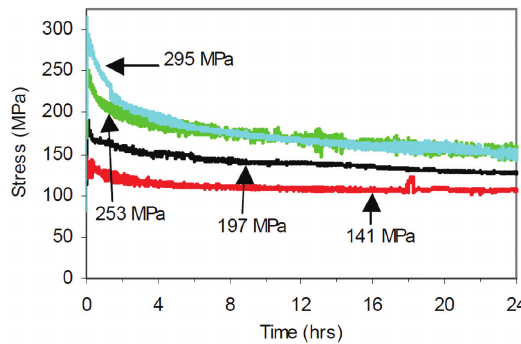
Figure 3. Example of the effect of initial stress level on the creep- relaxation behavior of 7475, during age-forming using a 2nd stage temperature of 160°C [10] .